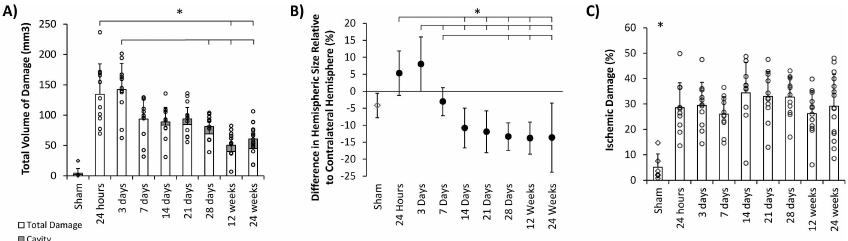
Fig 2. Ischemic damage over time after stroke. A) Total volume of damage including cavity (shaded). B) Changesin hemispheric size C) Ischemic damagecorrected for the effect of oedema and atrophy. All values Mean ± Standard Deviation. Animals are represented by individualdata points. * p <